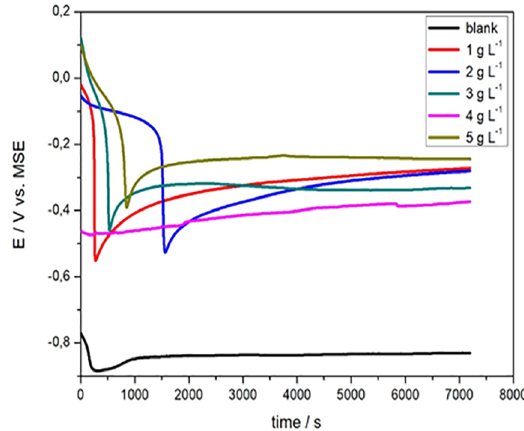
Figure 4. OCP plots for AISI 304 stainless steel in H2SO4, in presence and absence of